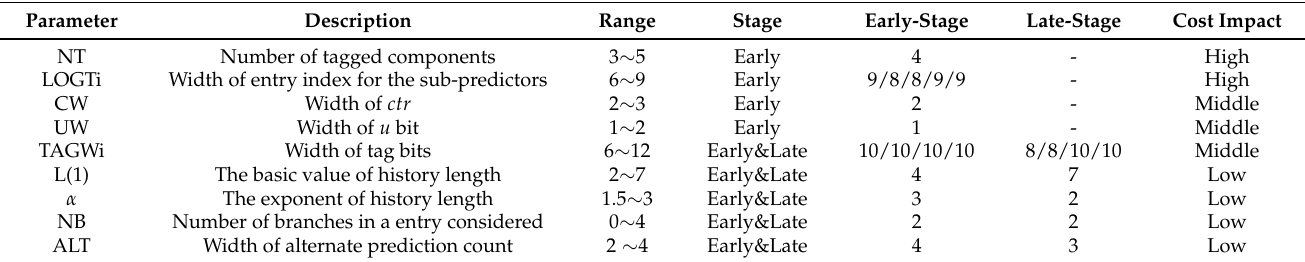
Table 5. Design options for TAGE predictor